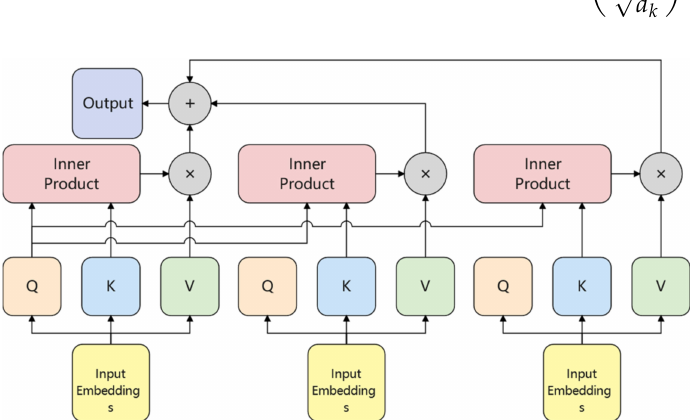
Figure 1. Attention mechanism.